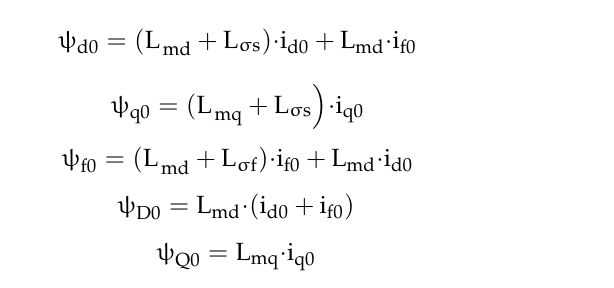
Figure 6. Synchronous machine equivalent diagram for q-axis adapted with permission from ref. [1]. Copyright 2021